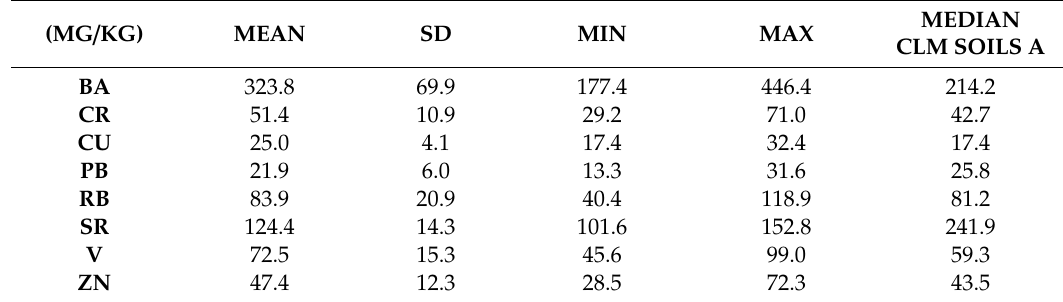
Table 4. Main statistics for elements (expressed in mg · kg − 1 ) analyzed in this